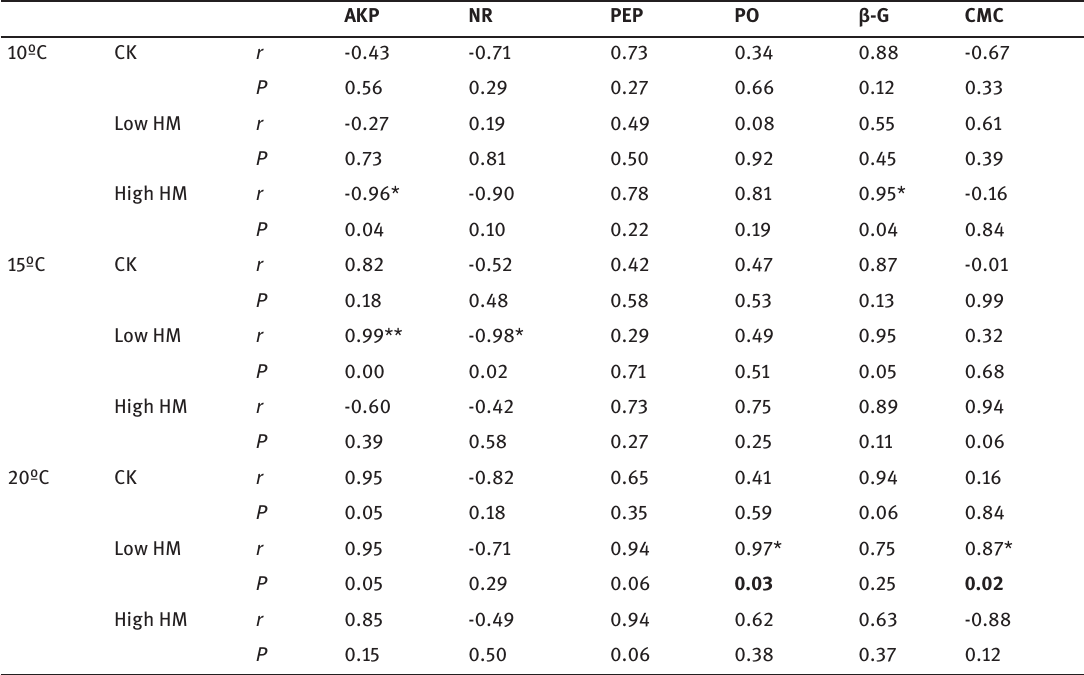
Table 3: Pearson’s correlation coefficients between enzymatic activities and litter mass losses in microcosms at three temperatures and two heavy metal (HM) levels for 100